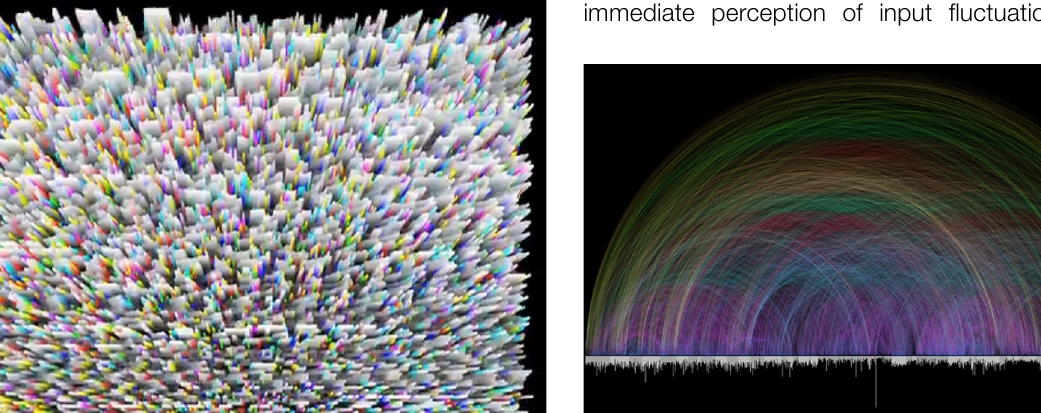
Figure 11 | Pure Data Read as Pure Data, Maigret, 2010. Figure 12 | Bible Cross-References, Harrison,